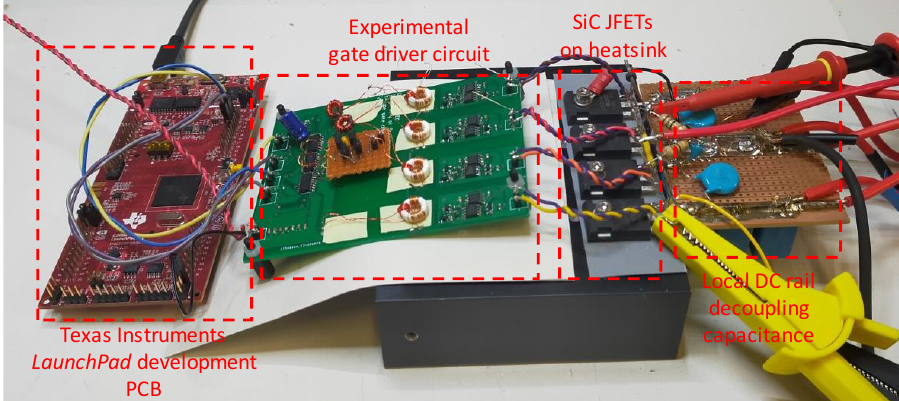
Figure 11. Experimental rig. Reinforced insulation was not included between the transformers’ primary and secondary windings in the experimental gate driver circuit.